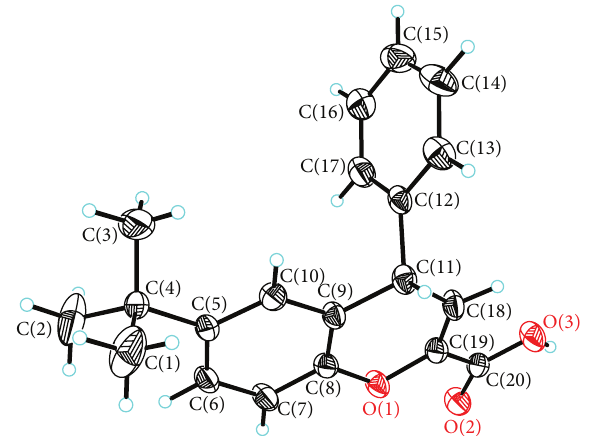
Figure 2: The X-ray structure of 4 H -chromene-2-carboxylic acid 8a .